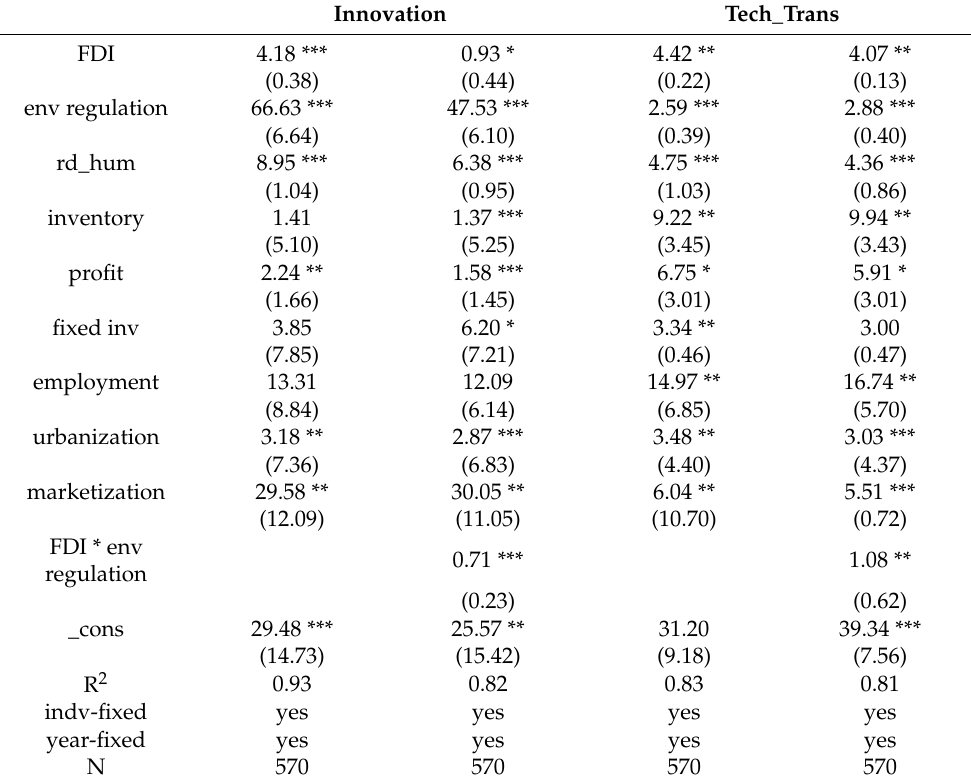
Table 5. Moderating effect of environmental